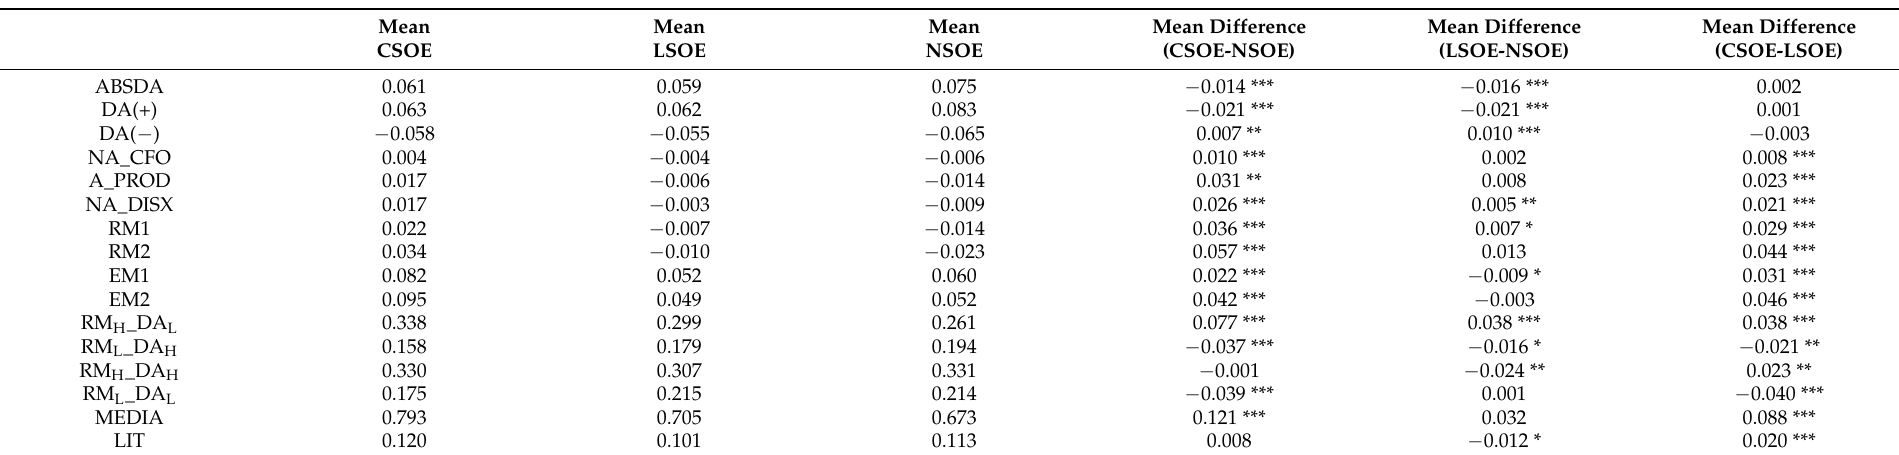
Table 4. Mean Values Partitioned by Ownership Type.